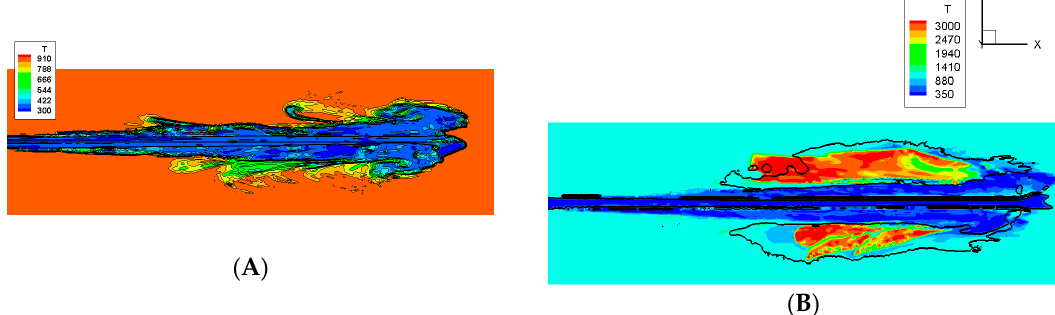
Figure 18. Extension to evaporating and reacting cases. ( A ) Temperature of an evaporating spray. The liquid fuel temperature is 300 K and the ambient air is 900 K. A low-temperature layer (dense droplet layer) surrounds the liquid core; ( B ) Temperature of a reacting (auto-igniting) case in the 1000 K air with one-step global reaction mechanism. Ignition initiates from the outer layer edge where the fuel vapor mixes with the outer air. The solid line indicates the stoichiometric condition.